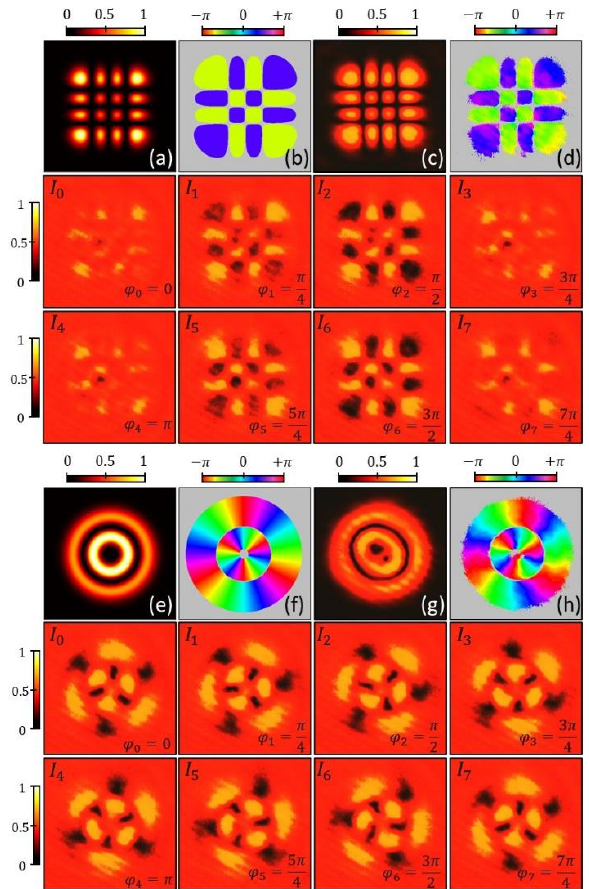
Fig. 2. Realization of a HG 33 (a-d) and LG 13 (e-h) beam. Theoretical intensity (a,e) and phase (b,f) distributions. Experimental intensity (c,g) and phase (d,h) distributions. The phase distribution of each beam is retrieved from the interferograms shown below each case with eight consecutive phase shifts of step Δ𝜑 = 𝜋/4